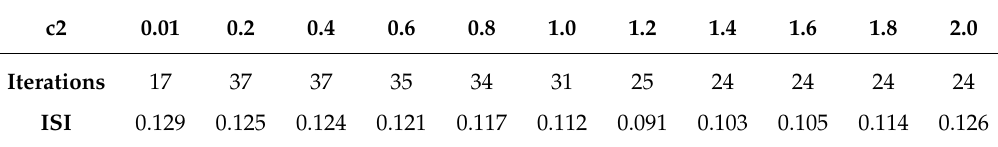
Table 1. The separation performance with varying c 2 .